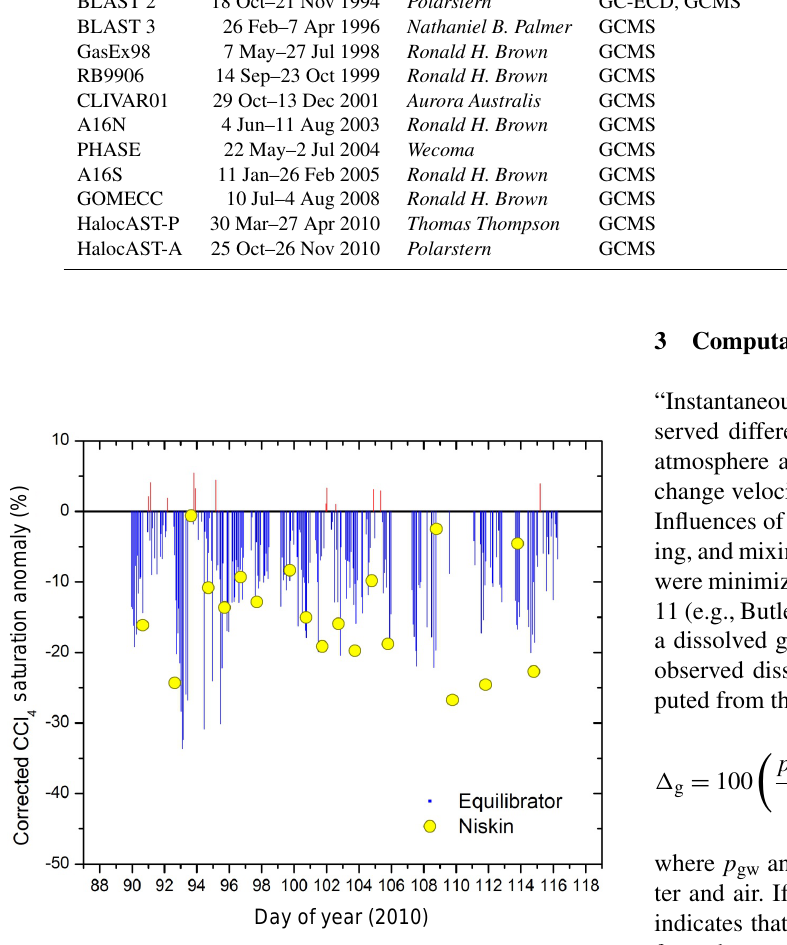
Figure 2. Corrected CCl 4 saturation anomalies determined from measurements of mole fractions in ambient air and air equili- brated with surface water in a Weiss-type equilibrator (blue bars) or extracted from near-surface grab samples (Niskin bottles; yellow points), showing no substantial bias in the equilibration technique for CCl 4 (Halocast-P, 2010; see Fig. 1, Table 1). Saturation anoma- lies in grab samples are calculated using solubility data from Bullis- ter and Wisegarver (1998). This good agreement suggests that the equilibrator does not bias results for CCl 4 and further suggests that the solubilities used to calculate saturation anomalies from discrete surface samples are